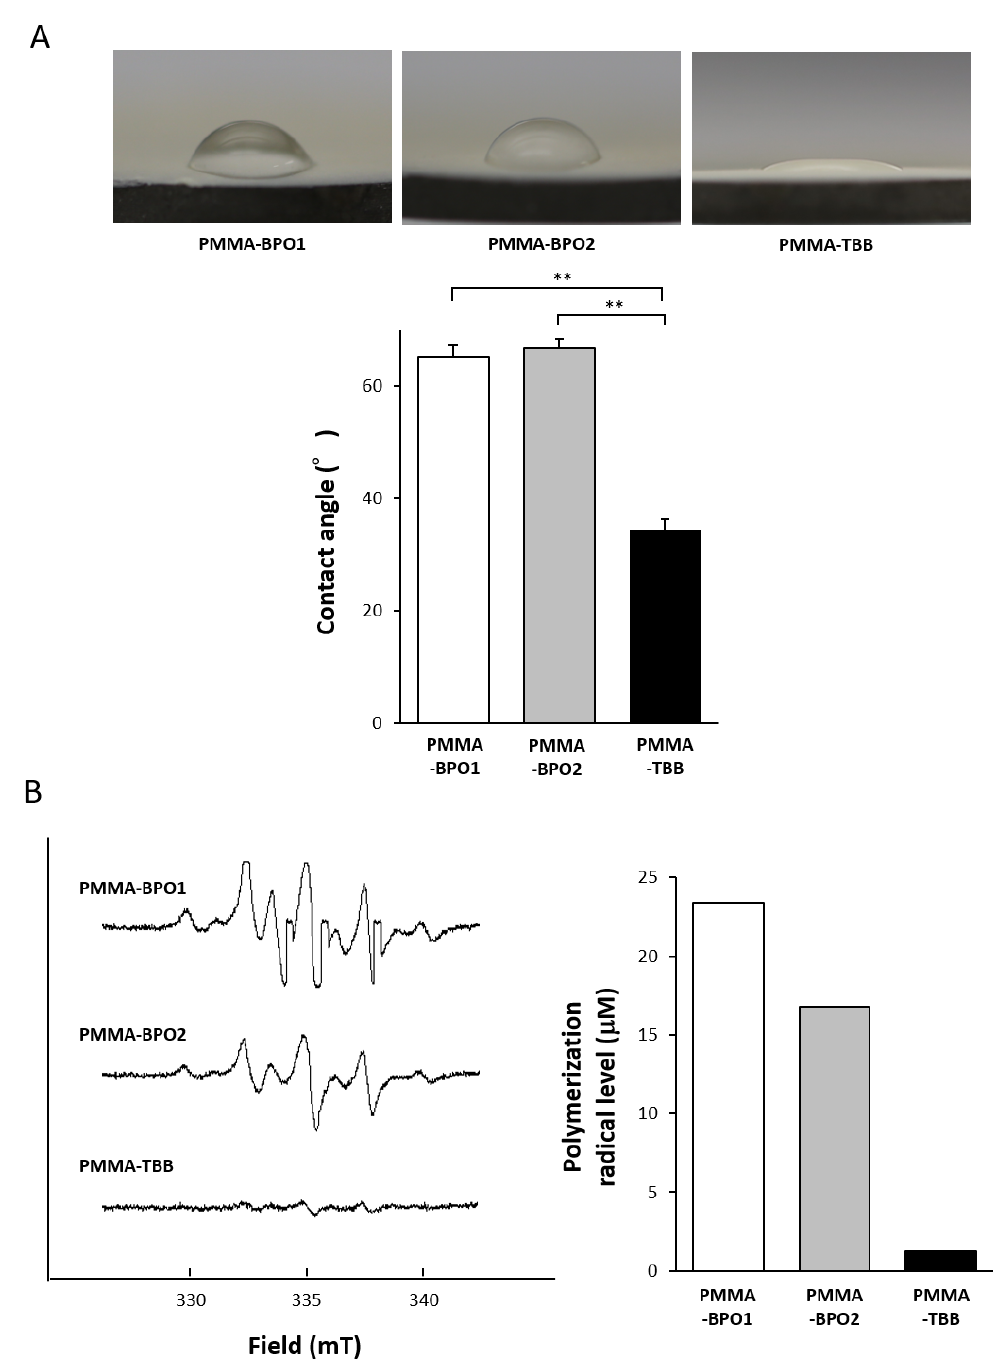
Figure 6. Characteristics of the contact angle and free radical generation on the di ff erent bone cement surfaces. ( A ) Hydrophilic / hydrophobic property of the surfaces of the three di ff erent materials. Bird’s eye view images of 10 µ L ddH 2 O placed on the materials after mixing the materials. The graph on the bottom represents the average contact angle of ddH 2 O for each surface. Each value represents the mean ± standard deviation of triplicate experiments ( n = 3). ** p < 0.01, one-way ANOVA followed by a Bonferroni test. ( B ) Free radical generation in polymerizing three di ff erent materials evaluated using electron spin resonance spectroscopy (ESR). ESR spectrums recorded 24 h after mixing materials.